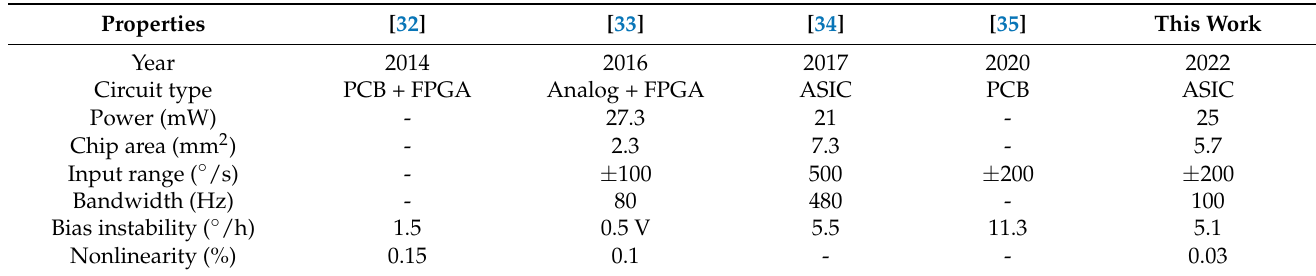
Table 2. Performance comparison and